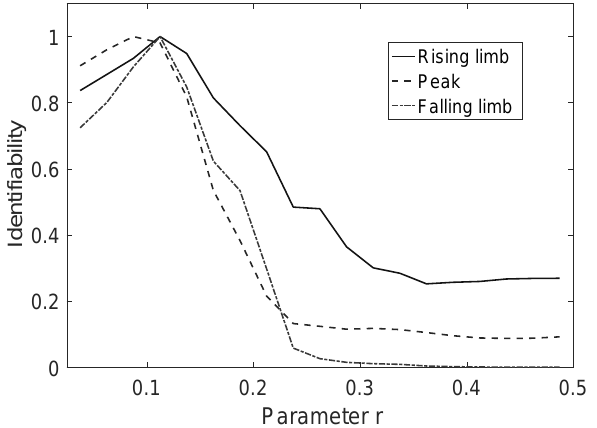
Figure 8. Identifiability against r parameter for all